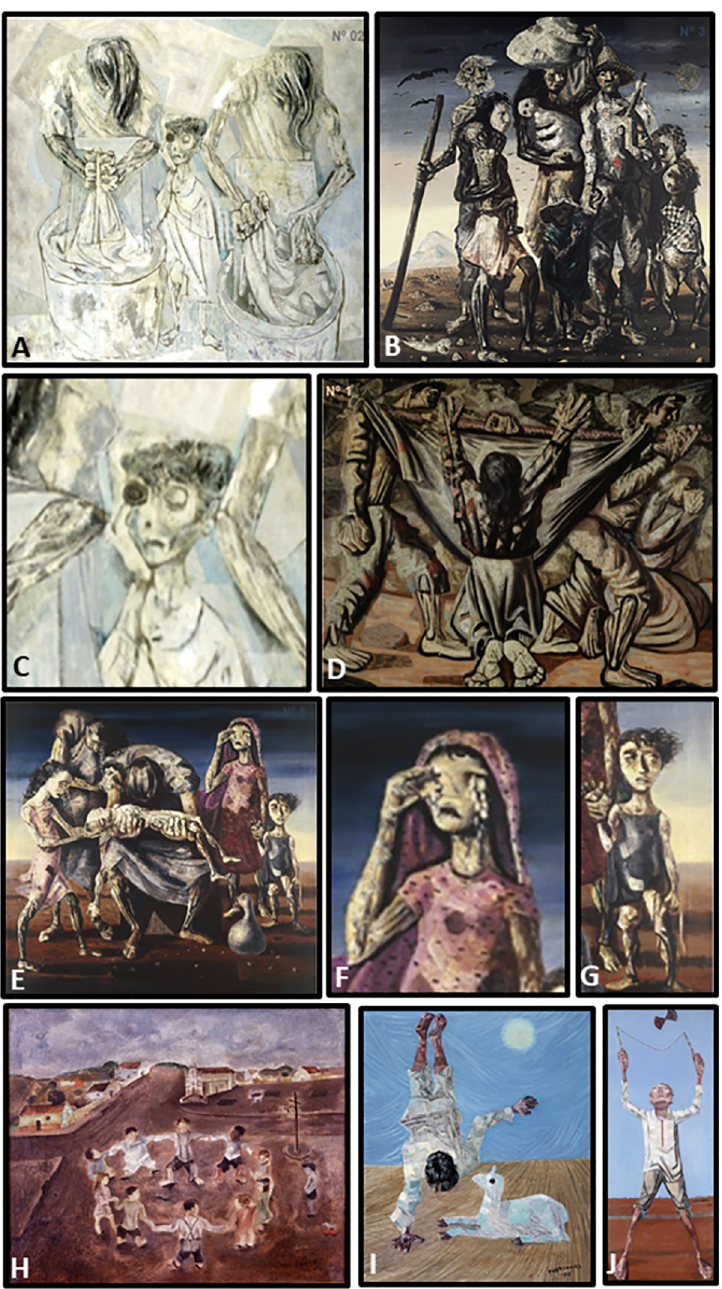
Fig 4. Images of some paintings of Candido Portinari presented to the participants in wagon 3: (A) “ Washerwomen ”, painted in 1944, size 170 x 200 cm; (B) “ Retreatants ”, painted in 1944, size 190 x 180 cm; (C) “ Washerwomen ”- detail of the central character with Roma ñ a´s sign in the left eye; (D) “ Burial in the hammock ”, painted in 1944, size 180 x 220 cm; (E) “ Dead Child ”, painted in 1944, size 180 x 190 cm; (F) “ Dead Child ”–detail of woman with falling tears; (G) “ Dead Child ”–detail of a child character with Roma ñ a´s sign in the right eye; (H) “ Children circle ”, painted in 1932, size 39 x 47 cm; (I) “ Upside down ”, painted in 1956, size 55 x 46 cm; (J) “ Diabolo ” (a game in which a two-headed top is thrown up and caught with a string stretched between two sticks), painted in 1959, size 154 X 75 cm. Their technical characteristics and museum locations are found in www.portinari.org.br.